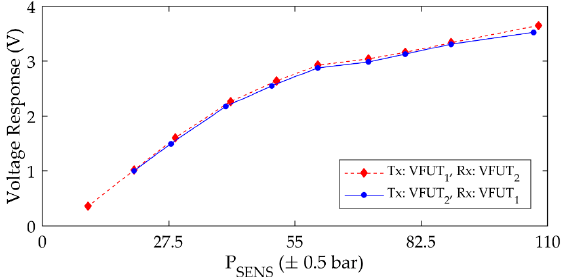
Figure 8. The voltage response as a function of air pressure level for VFUT 1 and VFUT 2 used alternately as T X and R X transducers. Note the (peak-to-peak) voltage response in each case is extracted from the first peak in the A-scan.